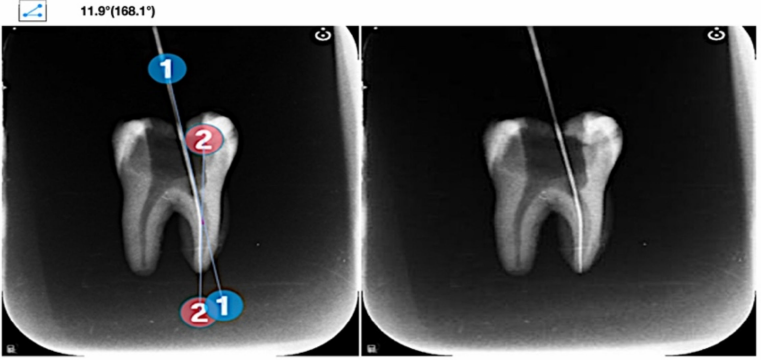
Figure 1. Measuring the root canal curvature on periapical radiographs according to Schneider’s method.